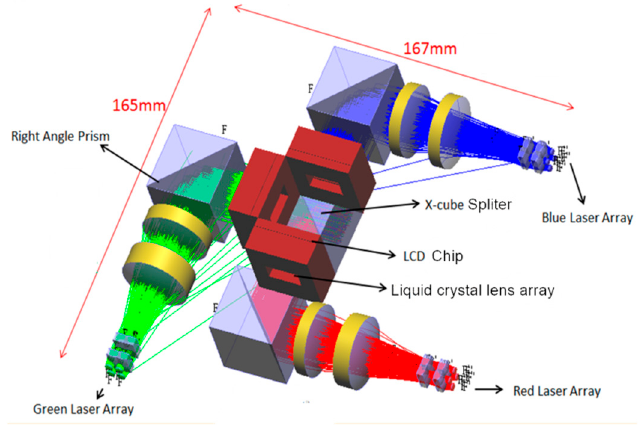
Figure 10. Overall structural diagram for the design of the projection illumination system for the projector. Table 3. Statistical table for the effectiveness of the projection illumination system for the projector.